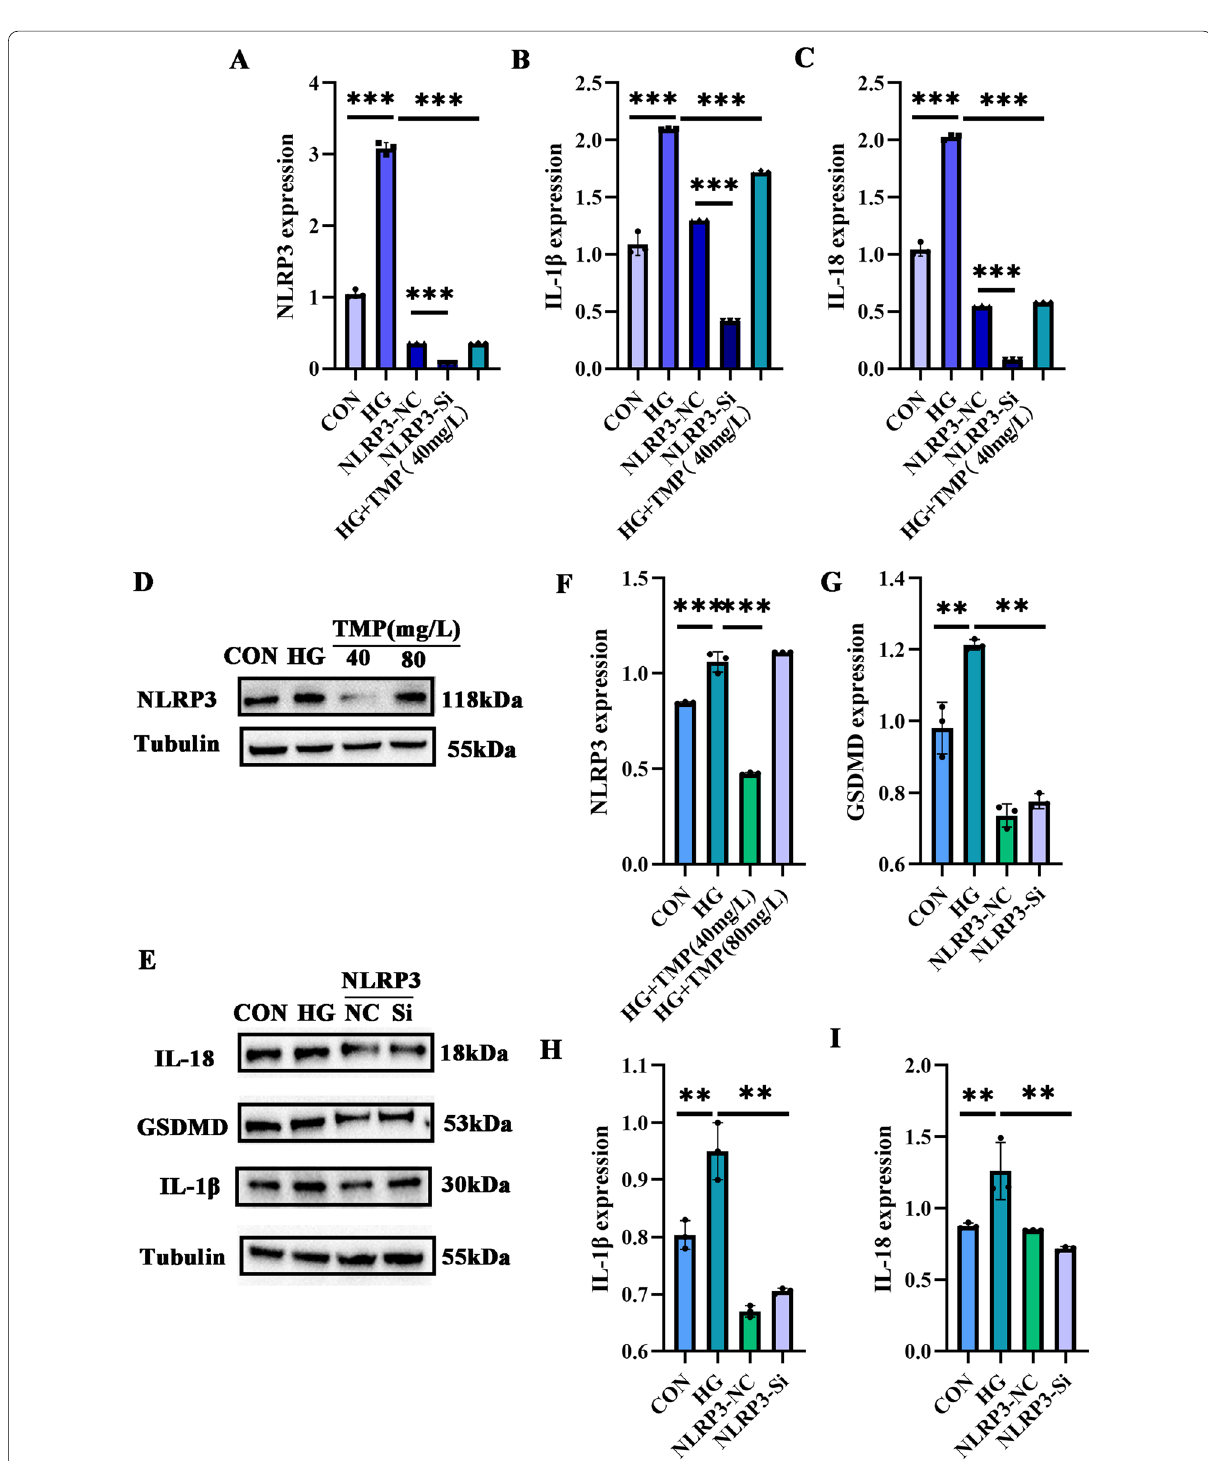
Fig. 6 A–C NLRP3-silence podocyte model construction, NLRP3, IL-1β, and IL-18 gene expression profiles after TMP intervention and NLRP3 knockdown models; D , E TMP at a relatively optimal concentration of intervention or NLRP3 silence; The expression of GSDMD, NLRP3, IL-1β and IL-18. F-I: the protein expression of GSDMD, NLRP3, IL-1β, and IL-18 were analyzed statistically. * P < 0.05; ** P < 0.01; *** P <